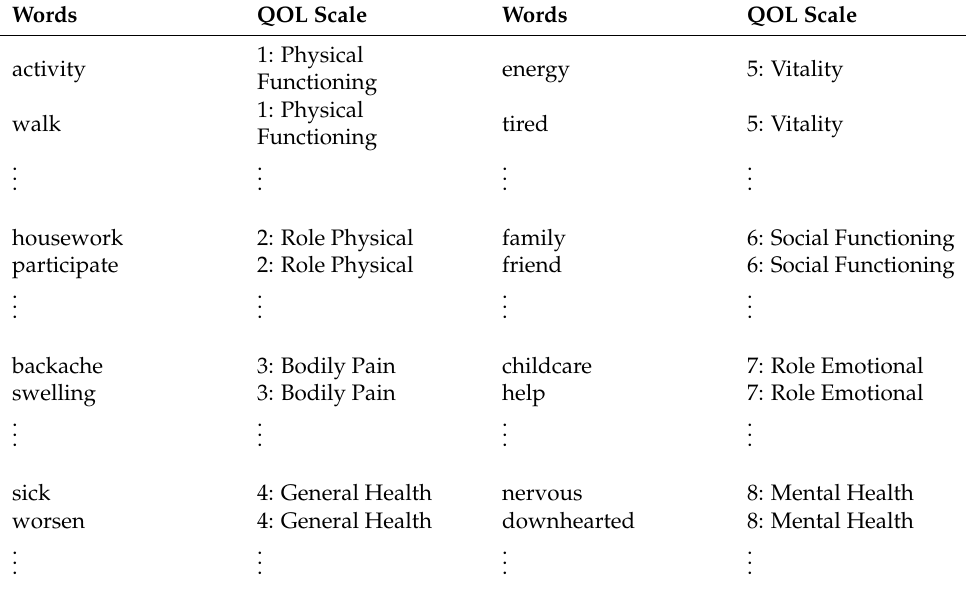
Table 1. Excerpt from